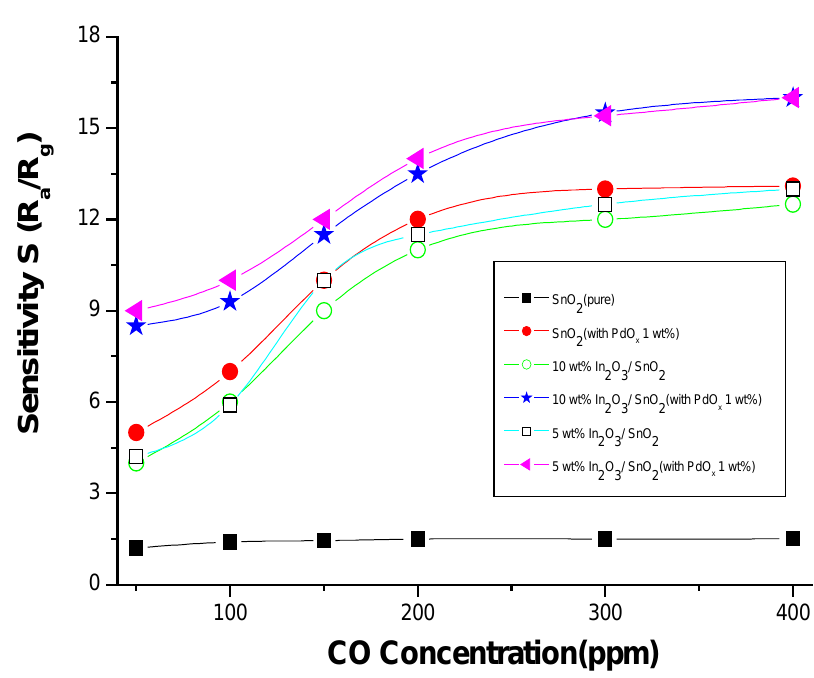
Figure 6. Sensitivity of the sensor films with different composition in accordance against CO gas at the working temperature 200 o C.